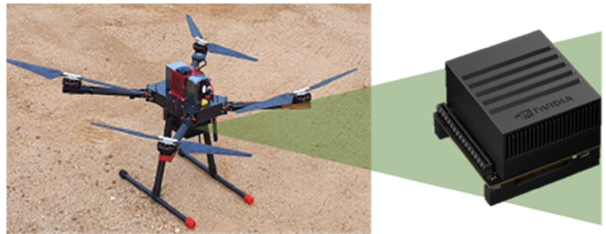
Figure 11. Anti ‐ spoofing enabled drone and NVIDIA Jetson AGX Xavier. Figure 11. Anti-spoofing enabled drone and NVIDIA Jetson AGX Xavier.